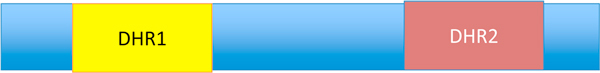
Organization of the DOCK8 protein.